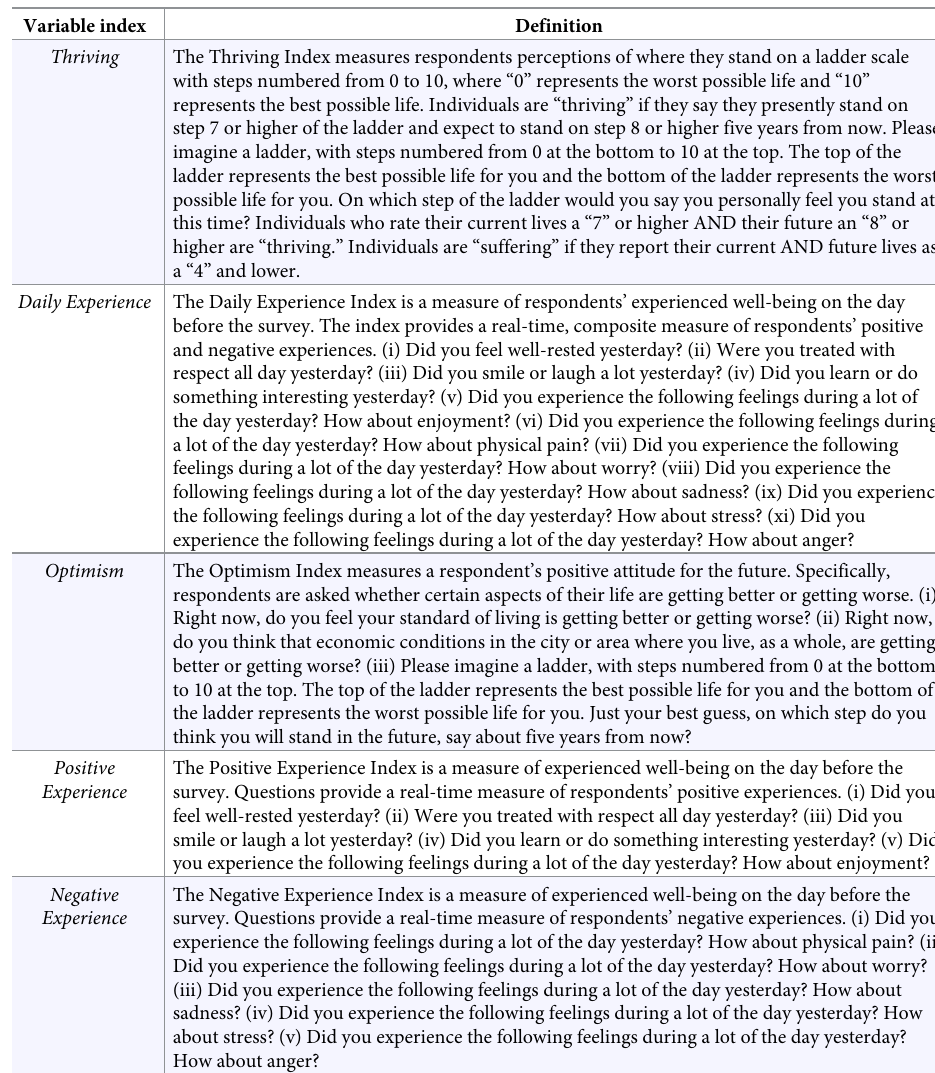
Table 1. Definitions of human flourishing